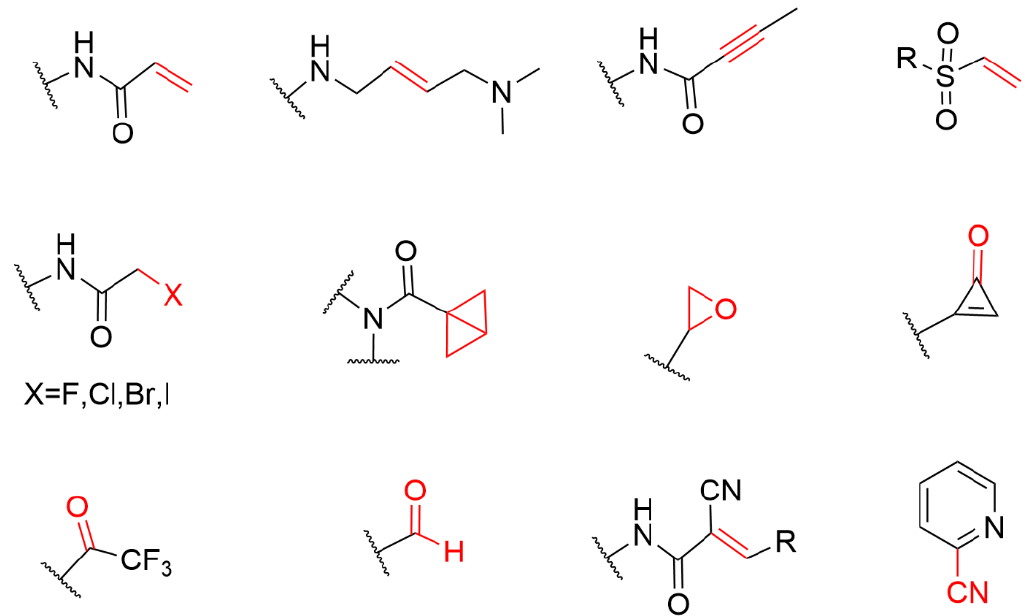
Figure 2. The general structure of the electrophilic library sorted by warhead chemistries.